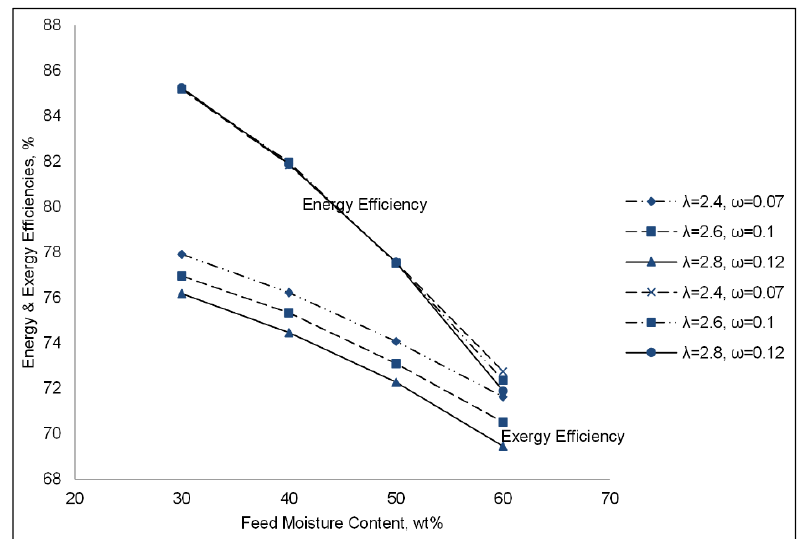
Figure 13. The effect of feed moisture content on the energy and exergy efficiencies of the system, T = 850 °C and S / B =